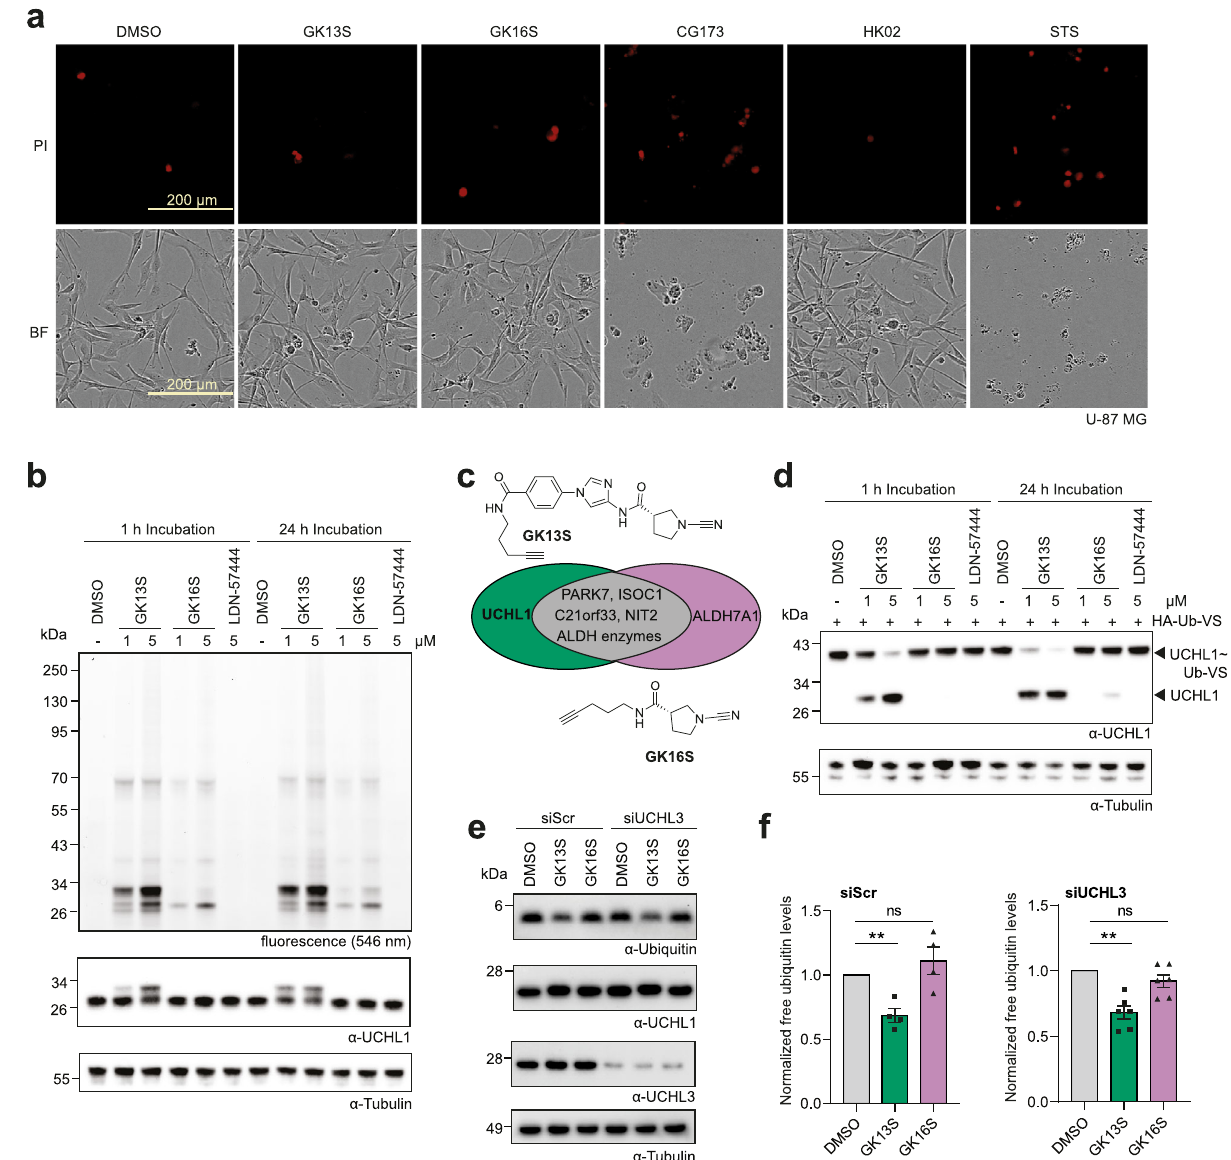
Fig. 4 | GK13S, but not GK16S, reduces monoubiquitin in U-87 MG cells and thereby phenocopies the effect of a UCHL1 mutant mouse. a Representative Fig. 7a – d for quantitation. b Cellular activity-based protein pro fi ling of intact U-87 MG cells treated with indicated compounds or DMSO for 1 or 24h. c Schematic representation of overlapping and individual cellular targets of GK13S and GK16S, supporting their application as chemogenomic probes for the investigation of UCHL1. Compare Fig. 2e. d Inhibition of cellular UCHL1. Western blot analysis of endogenous UCHL1 labeled with HA-Ub-VS after treatment of U-87 MG cells with either the indicated compounds or DMSO for 1 or 24h. e Western blots showing